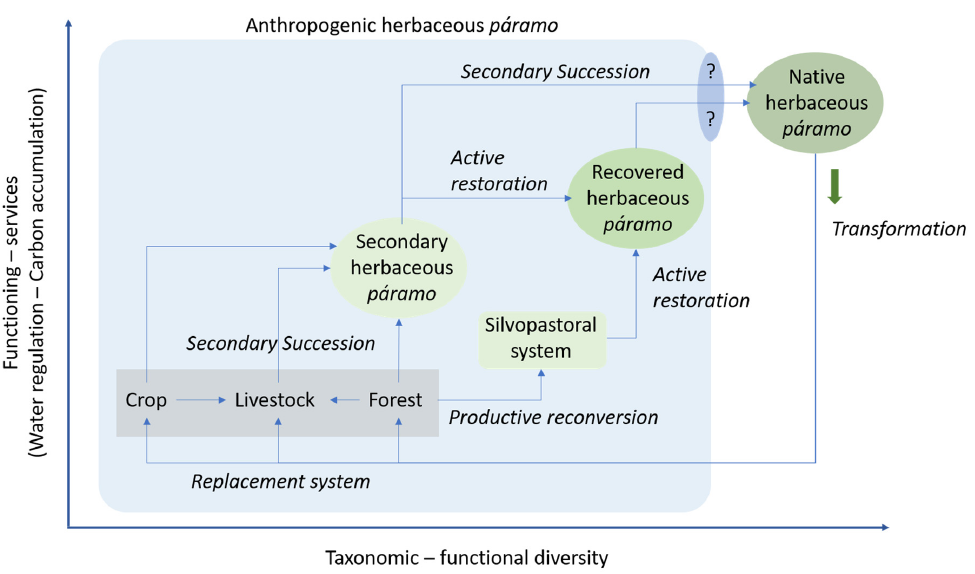
Figure 6. Possible evolution paths of taxonomic–functional diversity and ecosystem functioning services in different land-use scenarios [33].